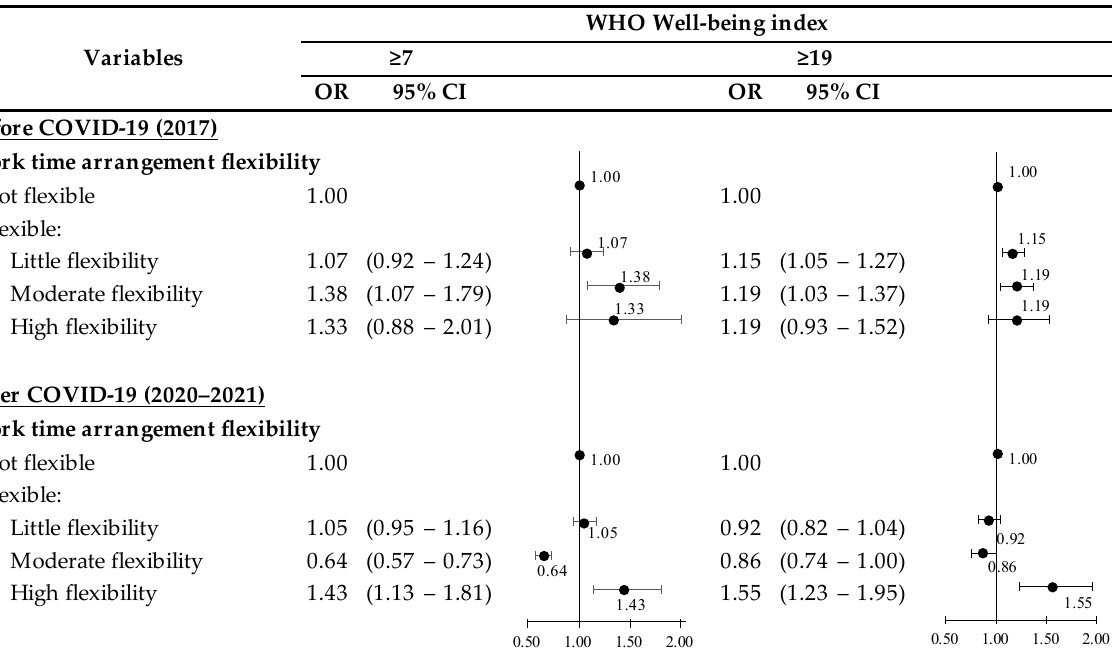
Figure 1. The results of subgroup analysis stratified by independent variables and year.